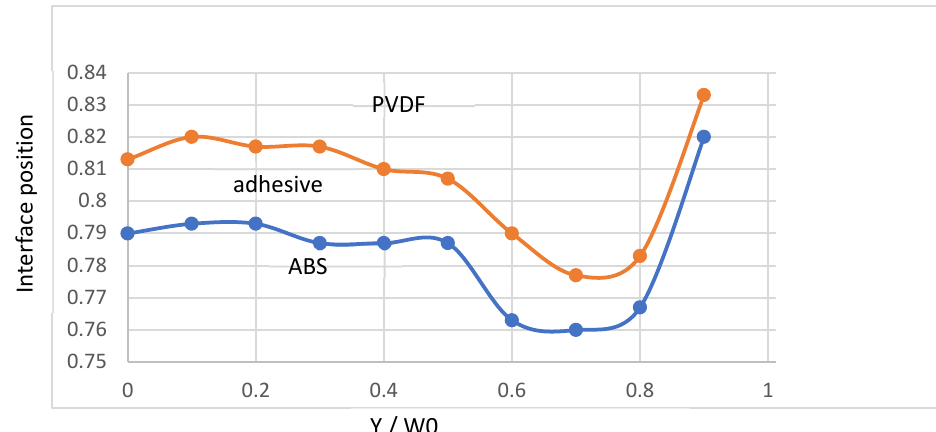
Figure 23. Coat-hanger die geometry. Only half of the geometry is represented (Reprinted from Ref. [2]).